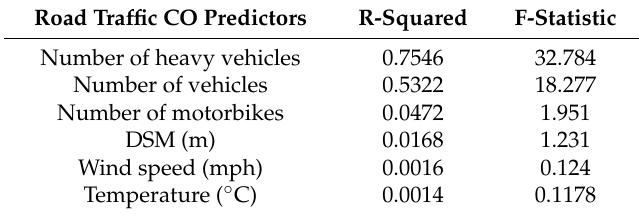
Table 4. Results of assessing the contribution of traffic CO predictors using the Chi-square method.